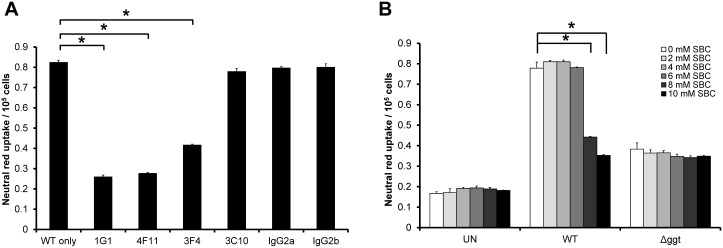
Inhibition of GGT activity decreases H. pylori-induced vacuolation.(A) H. pylori WT was pre-incubated with GGT MAbs (10μg) for 1 hour before they were used to infect AGS cells for another 24 hours. Mouse IgG2a and IgG2b isotype controls were used in parallel at the same concentration. (B) AGS cells were co-cultured with H. pylori WT or Δggt in the absence or presence of SBC (2-10mM). Uninfected cells (UN) served as control. The cells were then subjected to neutral red dye uptake assay. Experiments were performed in triplicates and values represent the means ± SD from 3 independent experiments. *P<0.05.